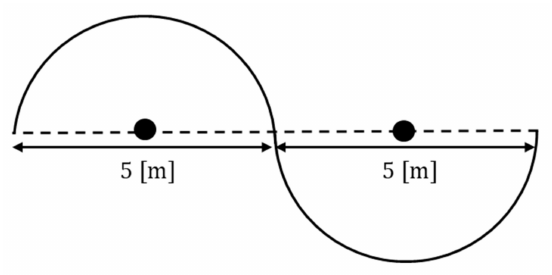
Figure 15. S-curved path tracking